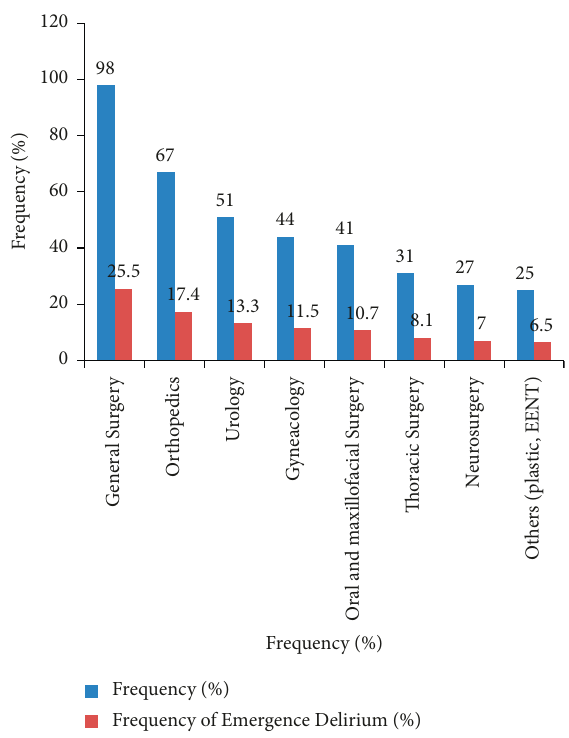
Figure 1: The frequency of types of surgery done and the prev- alence of emergence delirium in older patients who underwent elective surgery at teaching hospitals of Ethiopia.